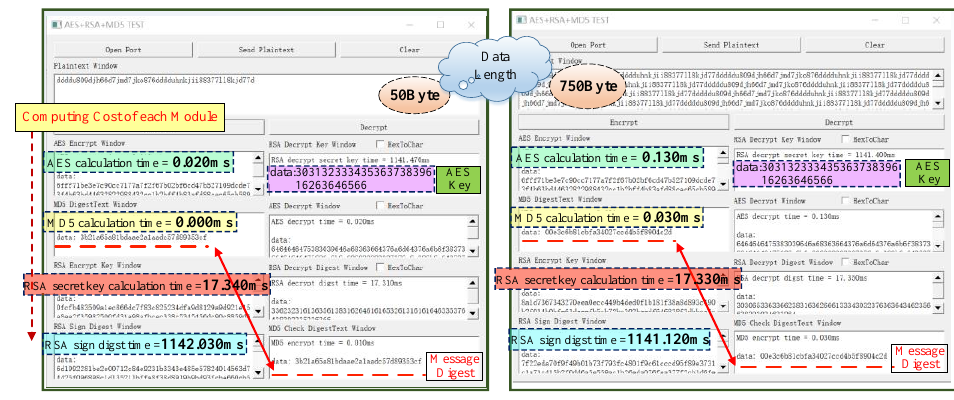
Figure 10. Scheme test interface.